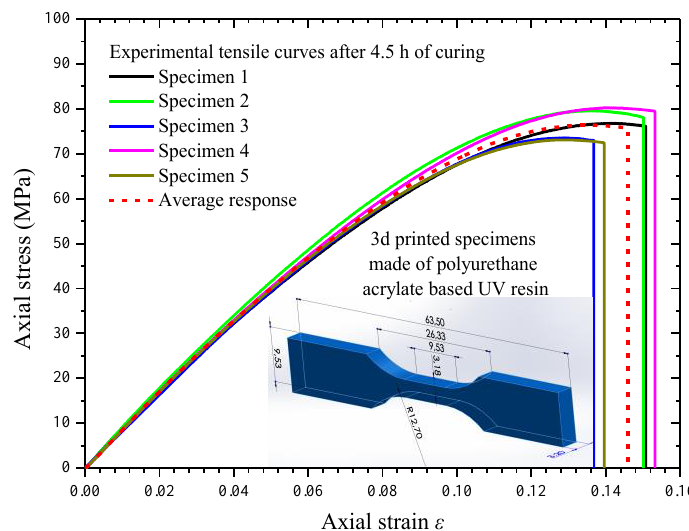
Figure 4. Experimental stress – strain curves for the 3D-printed